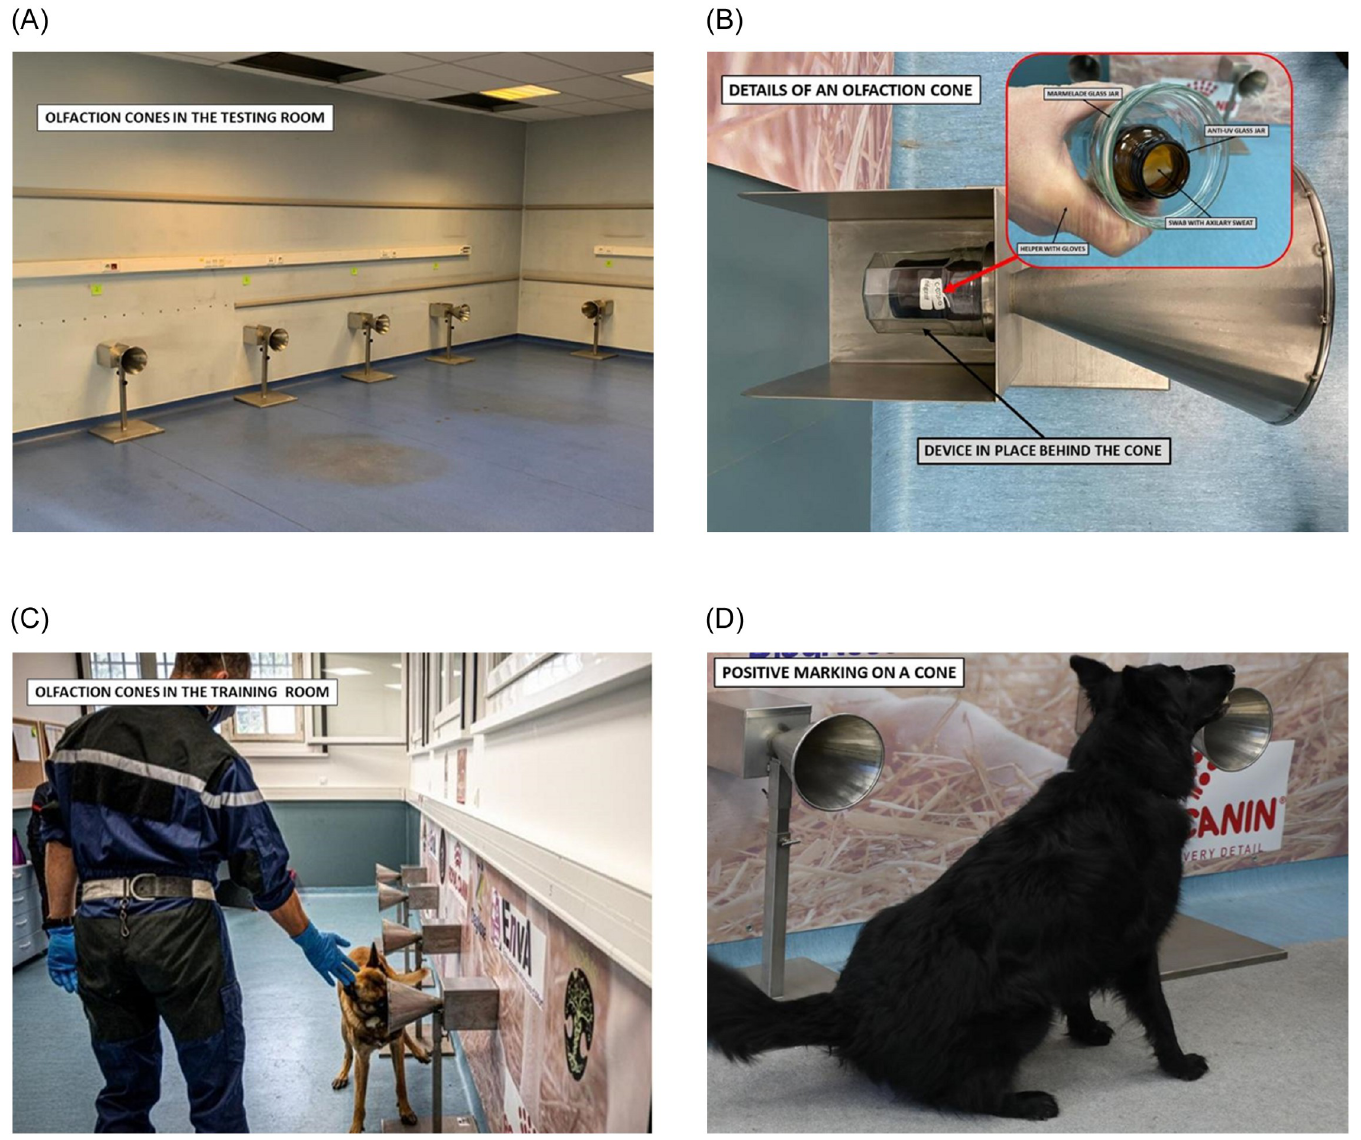
Fig 1. A: Testing room with its olfaction cones. B: Details of an olfaction cone, with a double-protected sample and no possibility of direct contact with the dog. C: Process involving olfaction cones and dog. D: Positive marking by a dog, sitting in front of a cone containing a positive sample.